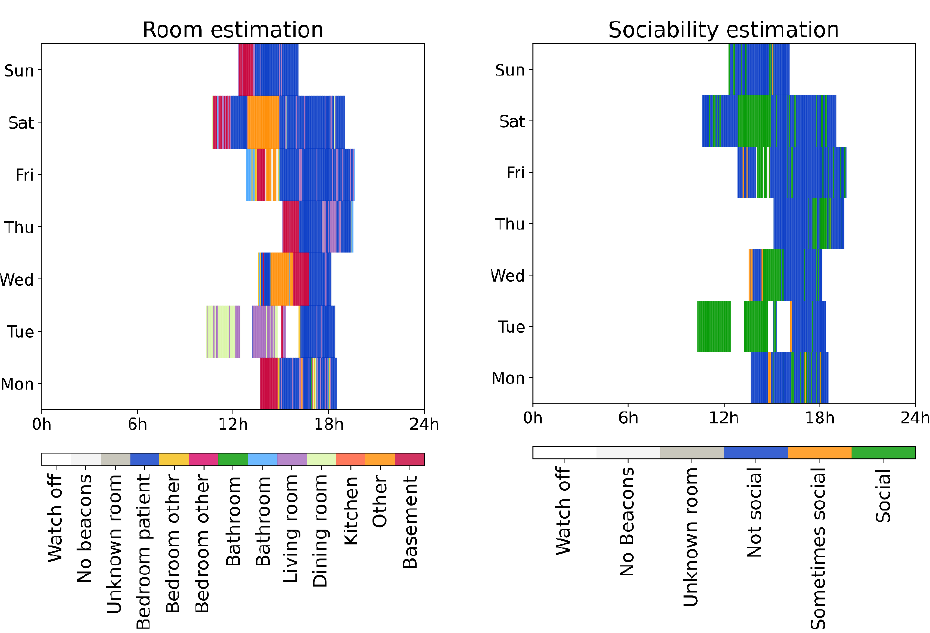
Figure 5. One-week long room ( left ) and sociability ( right ) estimation during the study, from a Monday to Sunday for a participant with ASD. ‘Watch off’ indicates that the participant was not wearing the watch; ‘No beacons’ that the participant has no registered beacon in the proximity wearing the watch, maybe outdoors; ‘Unknown room’ that the participant was at home, but the algorithm could not estimate the room the participant was in with confidence.